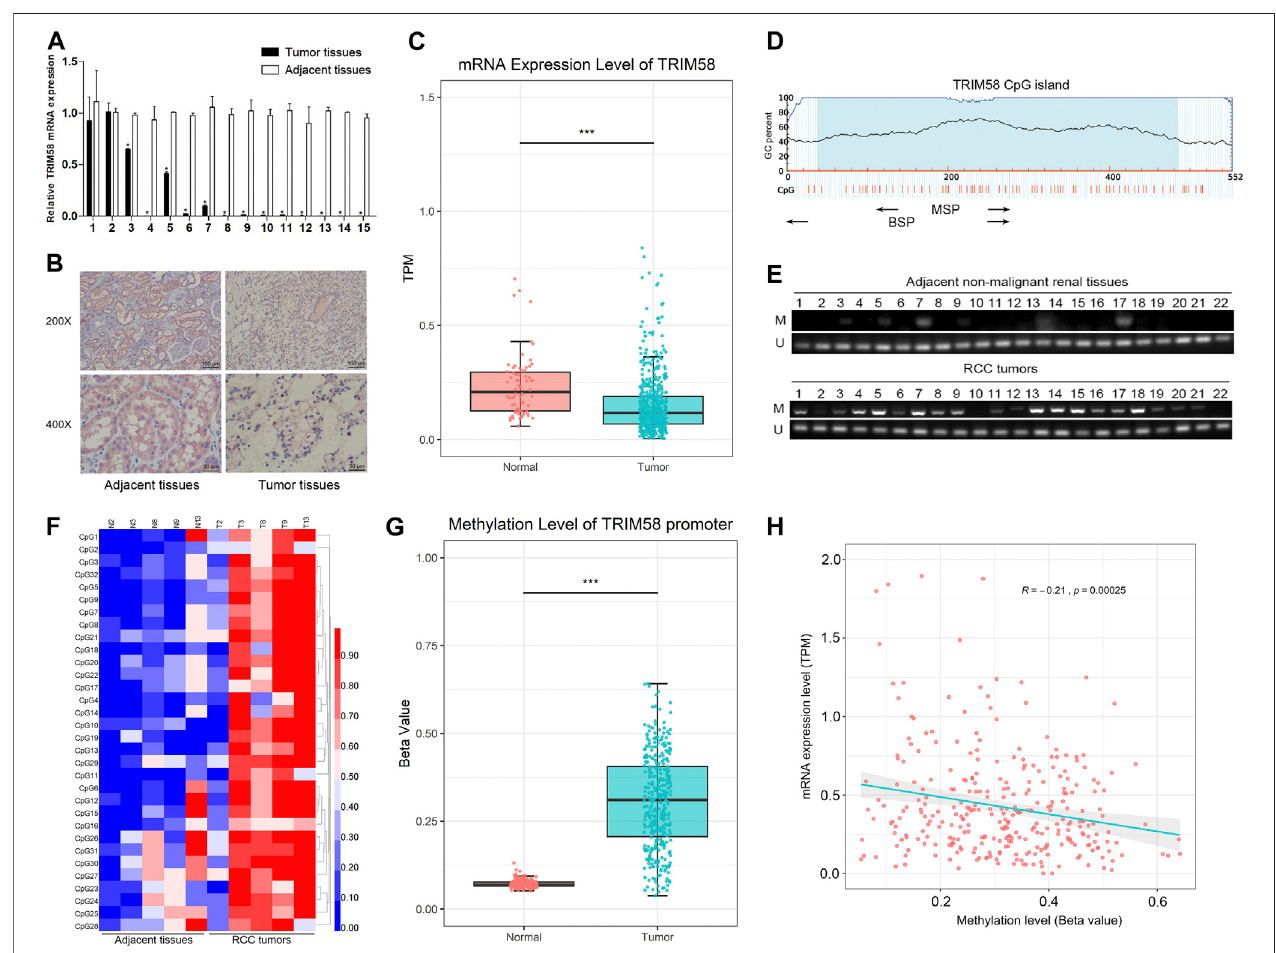
FIGURE1| TRIM58isfrequentlysilencedandhypermethylatedinccRCCsamples. (A) TherelativemRNAtranscriptionlevelofTRIM58in15pairedrenaltumortissues and the adjacent non-malignant renal tissues; (B) Representative IHC staining for TRIM58 in human ccRCC cancer (right panels) and adjacent normal renal tissues (left panels) ; (C) mRNA transcription level of TRIM58 in KIRC from TCGA database; (D) Primers targeting TRIM58 promoter region designed for MSP and BGS; (E) MSP analysisin92ccRCCsamplesand22adjacentnon-malignantrenaltissuesfromourcenter; (F) BGSanalysisonTRIM58promoter32CpGsitesof fi veccRCCsamples with paired adjacent tissues; (G) Methylation level of 317 KIRC patients from UALCAN; (H) Correlation analysis between the expression and methylation of